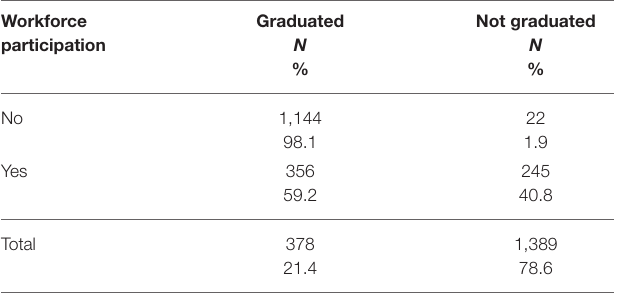
TABLE 3 | Chi-square test – differences in workforce participation and graduation among H-LSAMP participants.